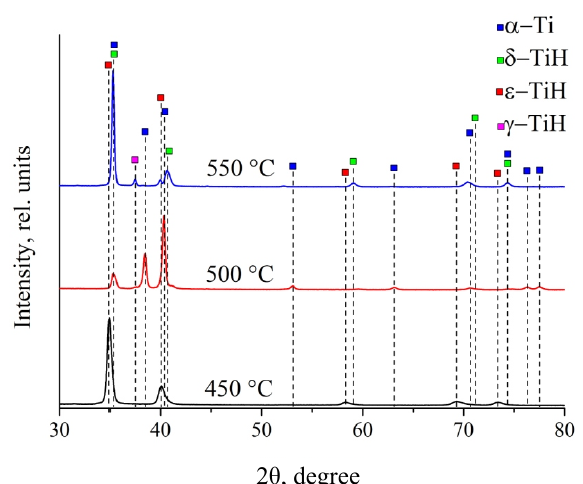
Figure 6. Diffraction patterns of the 20 µm Ti coating after hydrogenation at various temperatures. Figure 6. Di ff raction patterns of the 20 µ m Ti coating after hydrogenation at various temperatures. Table 3. Structural parameters of the 20 µm Ti coating after hydrogenation. Table 3. Structural parameters of the 20 µ m Ti coating after hydrogenation.